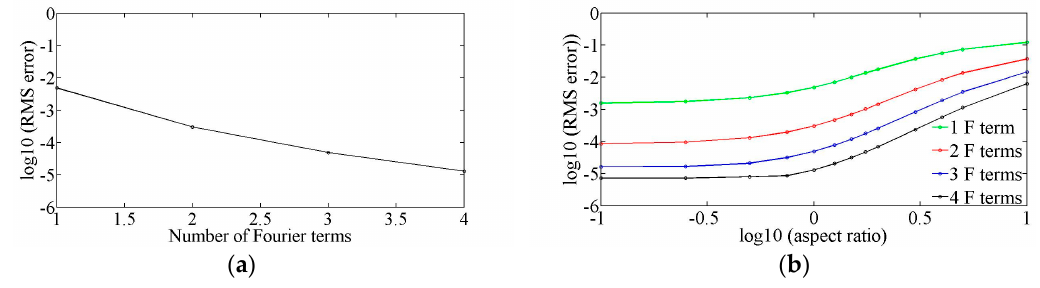
Figure 4. ( a ) Total cross-sectional root-mean-square error as a function of the number of Fourier terms included in the Q3D model for the square channel; ( b ) Aspect ratio, α = h error as a function of the number of Fourier terms included in the Q3D model.